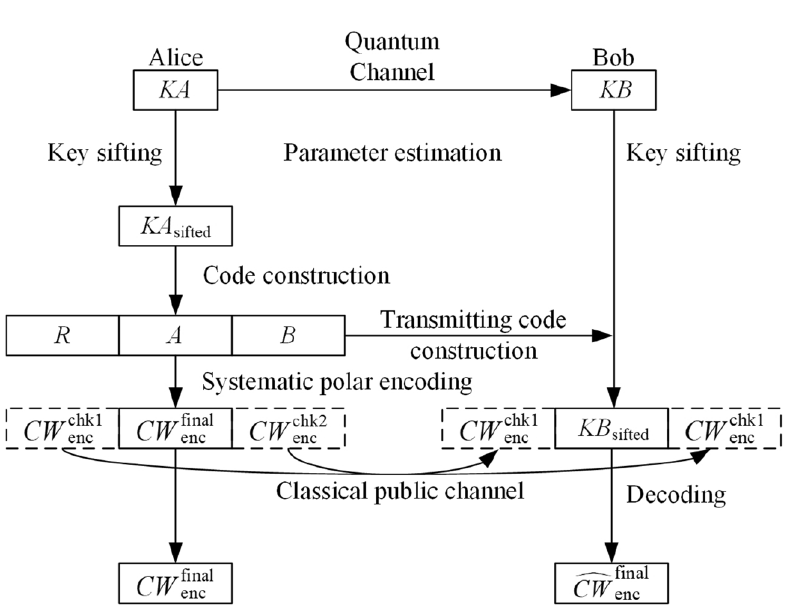
Figure 4. Polar-code-based efficient post-processing